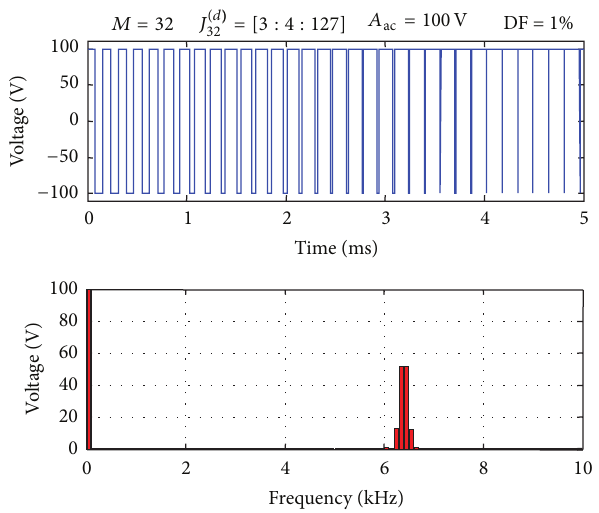
Figure 9: Optimal advanced design with 𝑀 = 8 switching cycles. PWM signal and harmonic distribution for the AC amplitude 𝐴 54 V with a fundamental frequency of 50 Hz and 𝑉